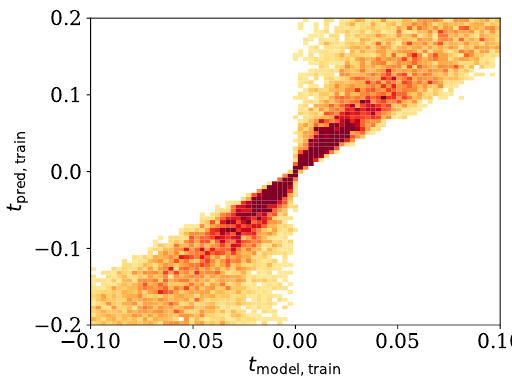
Figure 5: Correlation between the two pulls for the BNN, evaluated on the training